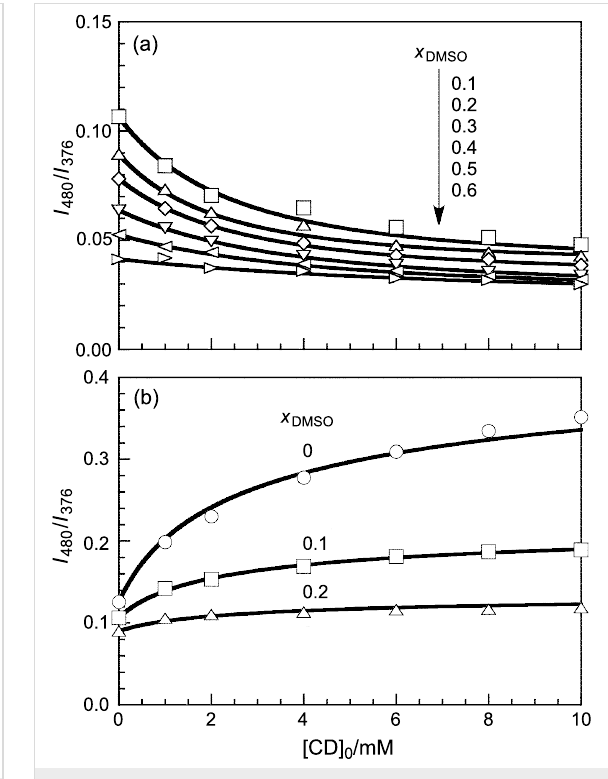
Figure 3: I 480 / I 376 as a function of [CD] 0 for β -CD/pAAmPy (a) and γ -CD/pAAmPy (b) at different x DMSO